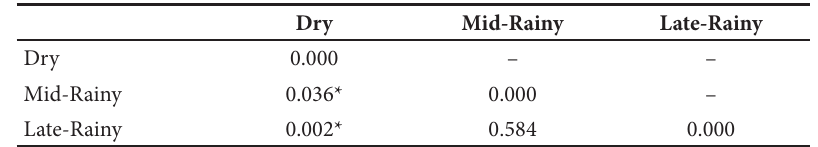
Table 5. Tukey’s HSD determine which seasons were significantly different from each other in terms of species numbers. Here, the p-values are displayed. An asterisk “*” denotes significance.